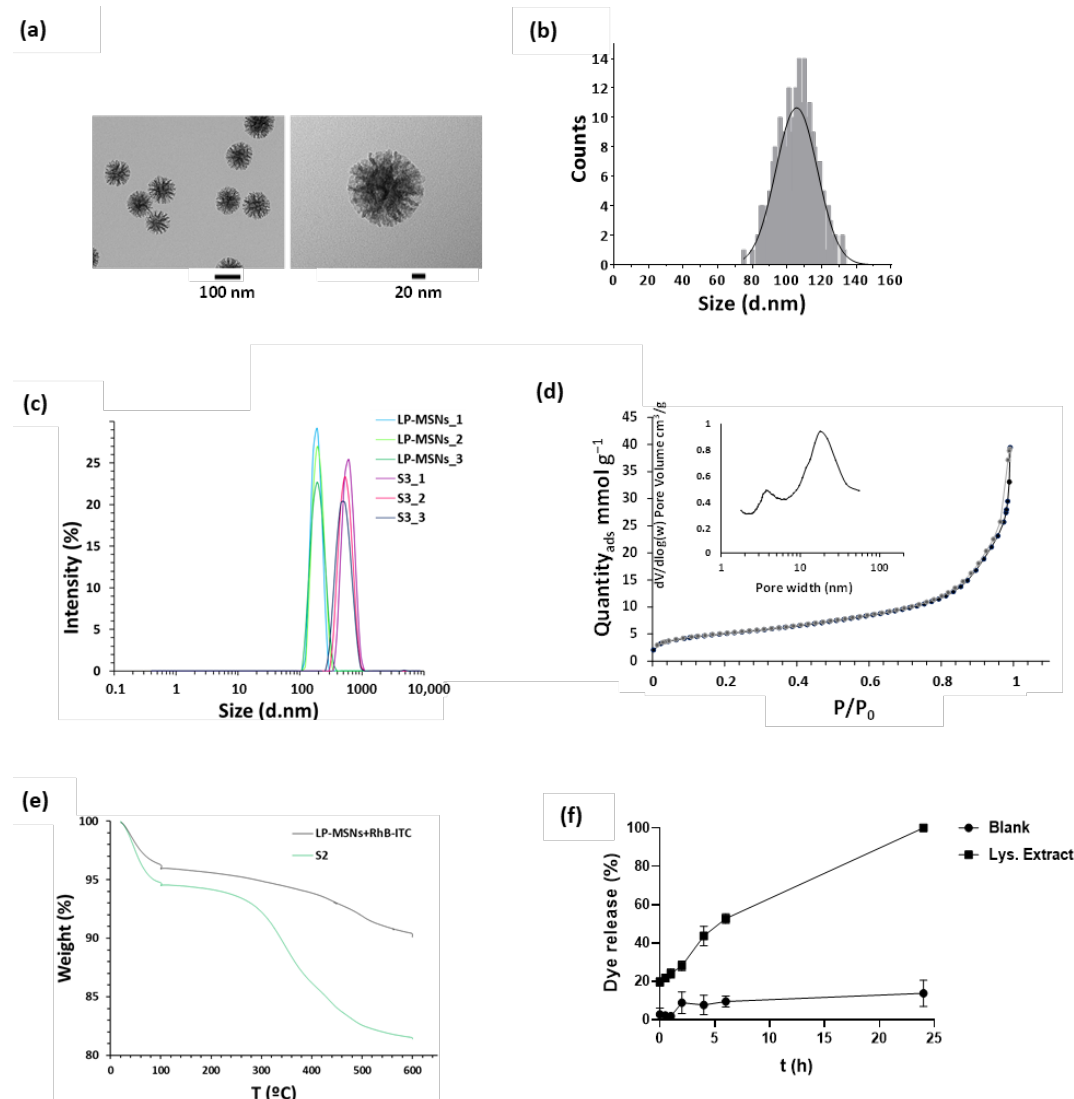
Figure 1. LP-MSN characterisation. ( a ) Representative transmission electron microscopy (TEM) im- ages of LP-MSNs. ( b ) LP-MSN size distribution obtained by measurements taken from TEM images. ( c ) Dynamic light scattering (DLS) intensity distribution of LP-MSNs and S3 nanoparticles size. Three